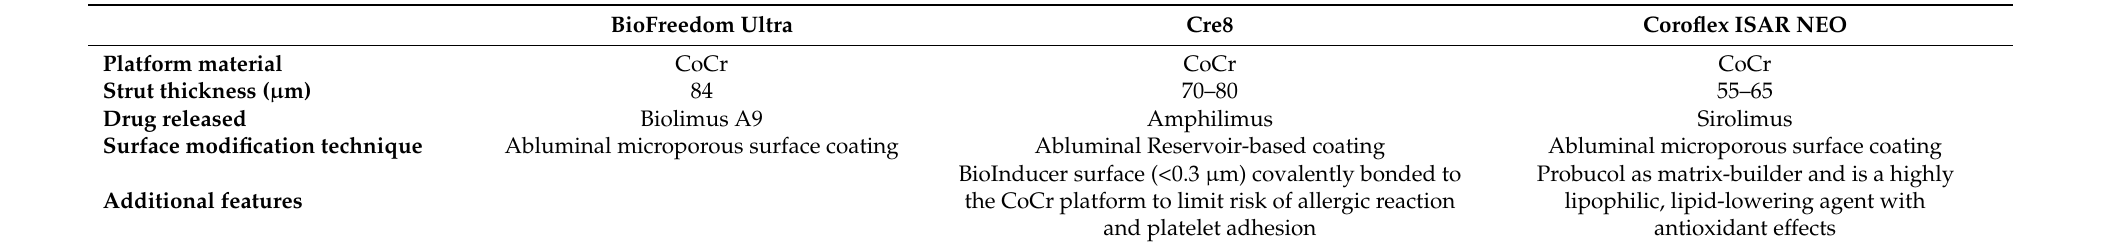
Table 3. Main features of polymer-free drug-eluting